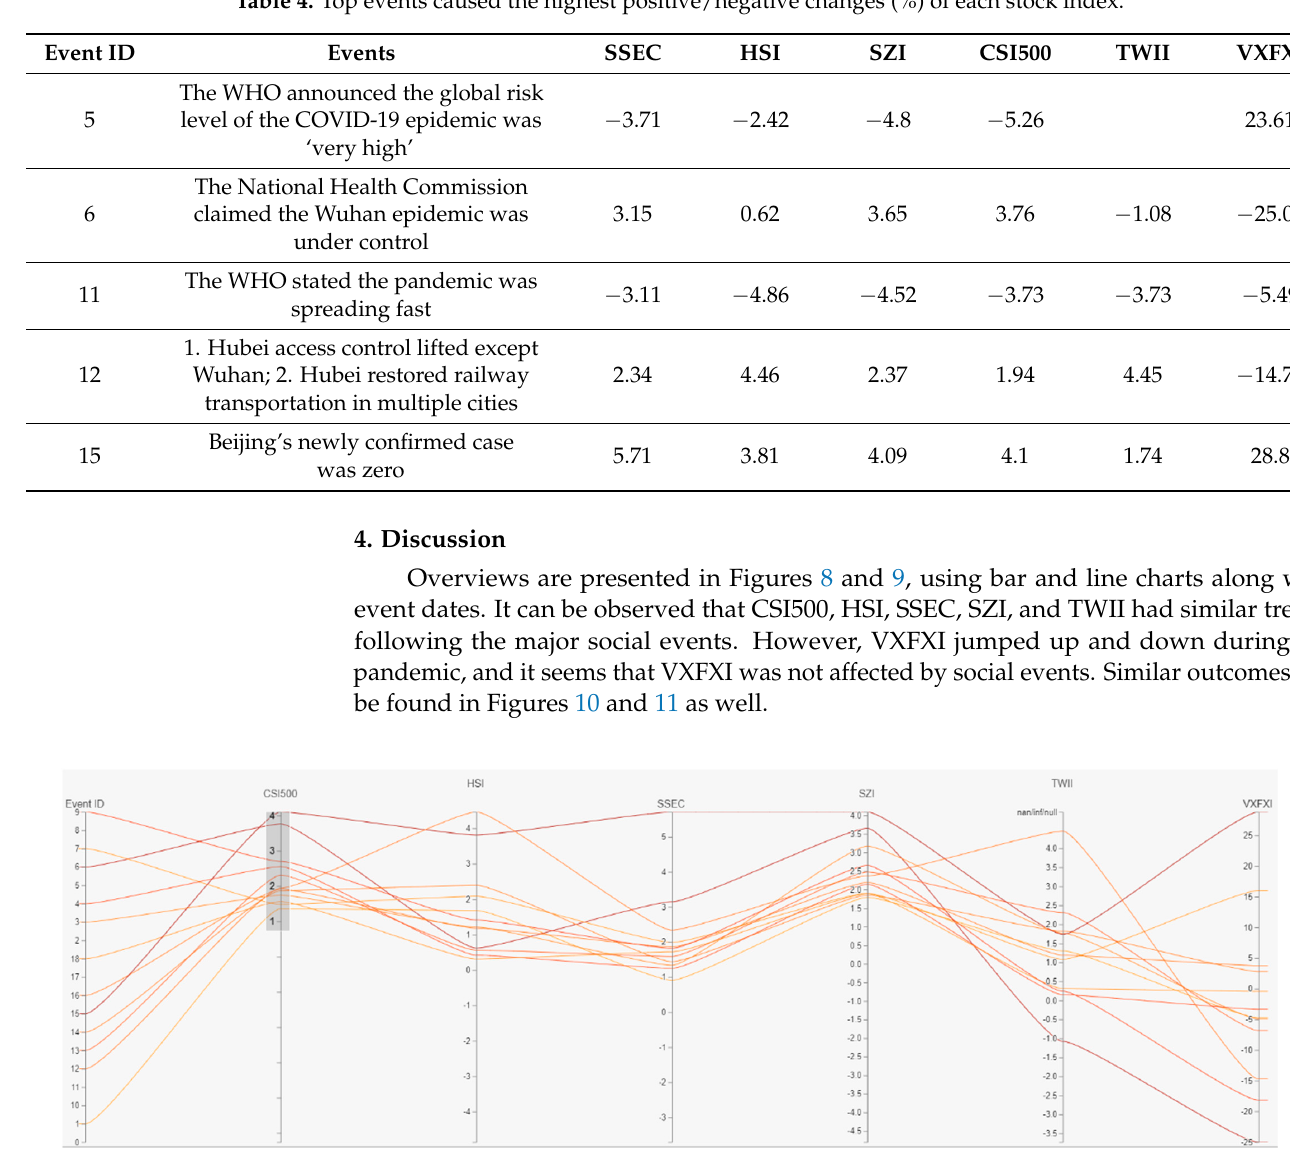
Figure 10. Positive events in most cases. (Darker colours indicate positive events that affect the CSI500 index more).